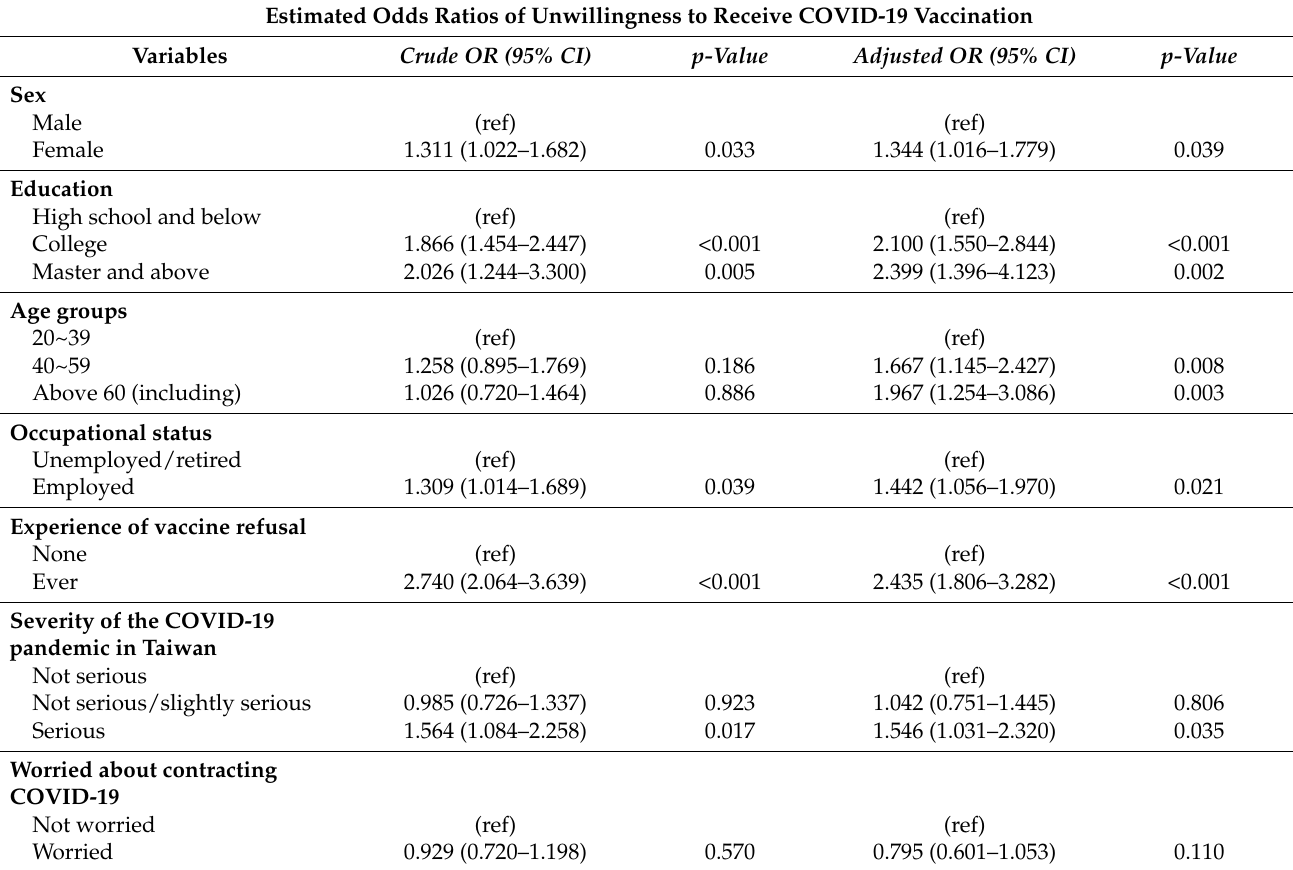
Table 3. Logistic regression model of unwillingness to receive COVID-19 vaccination.